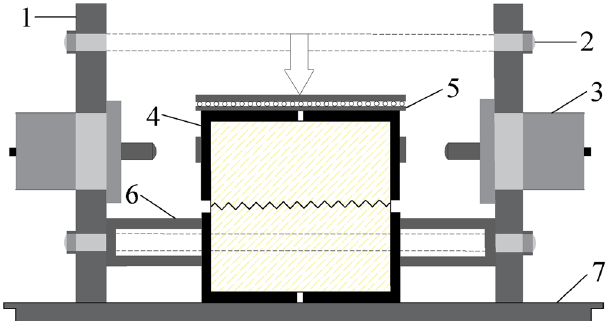
Figure 2. RJDT-A shear box schematic diagram. 1—Frame baffle; 2—Fixed screw; 3—Jack loading; 4—Shear box; 5—Skateboards; 6—Fixed roof; 7—Bottom board.